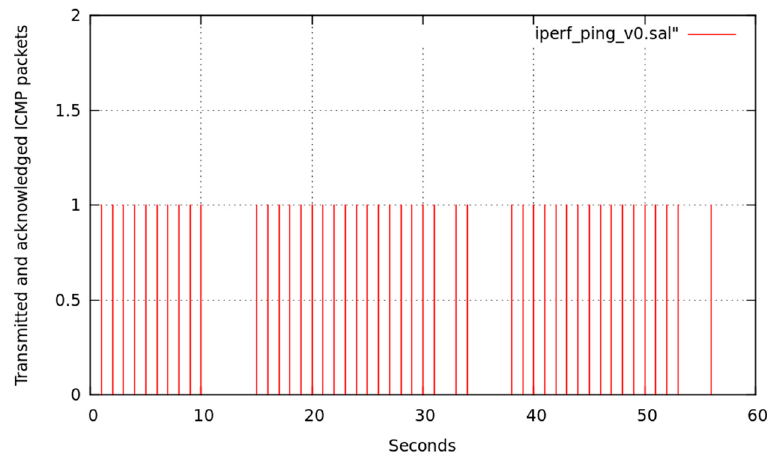
Figure 22. LFT messages confirmed by node6 from node1.